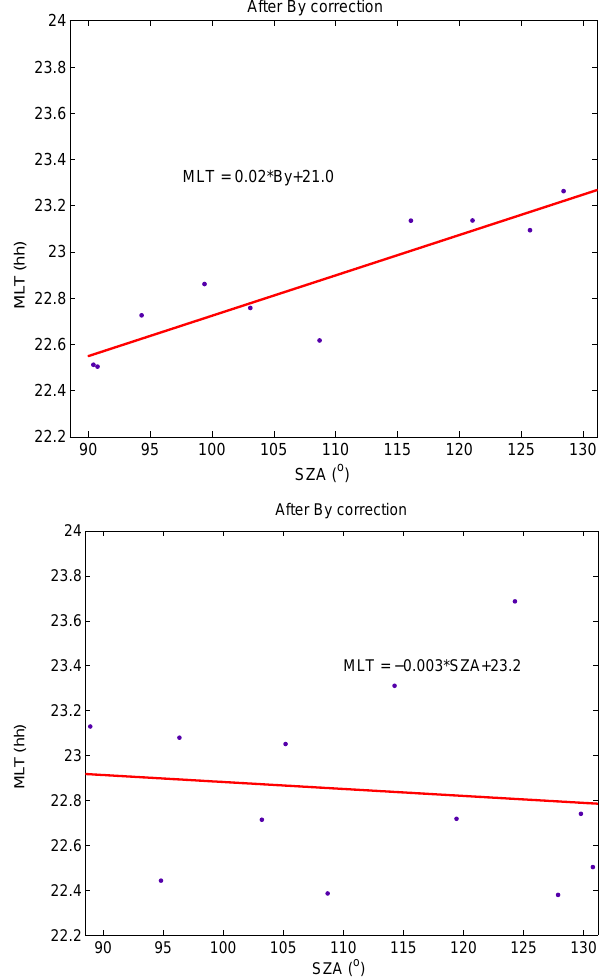
Fig. 10. Dependence of onset local time on solar zenith angle, SZA, after removal of IMF B y